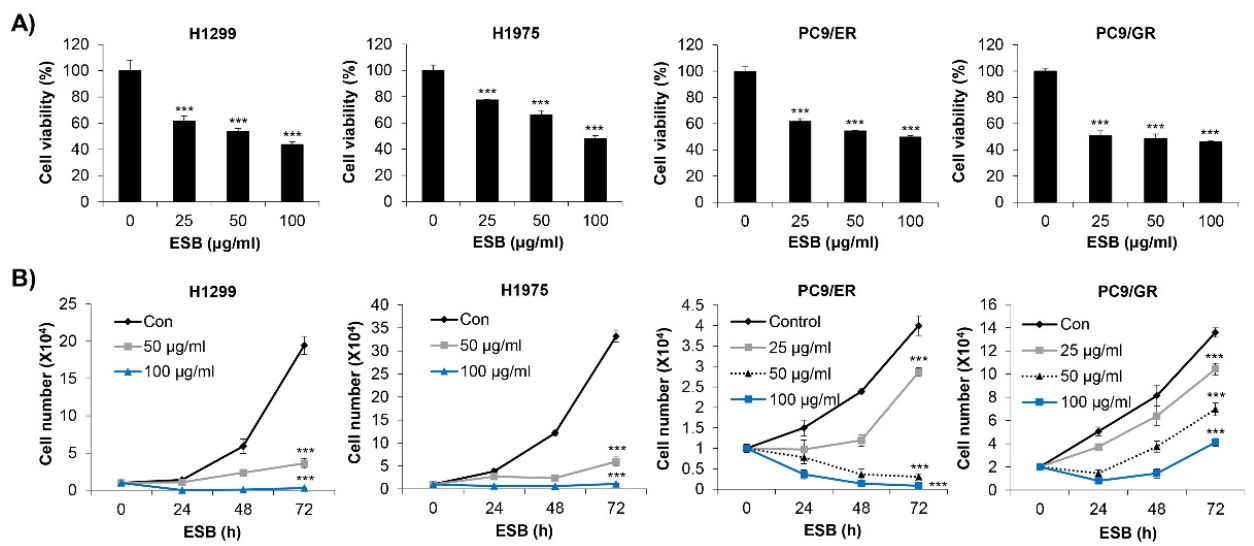
Figure 3. Effect of ESB on the cell growth of EGFR TKI-resistant human NSCLC cell lines. ( A ) H1299 ( EGFR wildtype; EGFR TKI-resistant), H1975 (acquired TKI-resistant), PC9/ER (acquired erlotinib-resistant), and PC9/GR (acquired gefitinib-resistant) human NSCLC cell lines were treated with different concentrations of ESB for 72 h. Cell viability was measured by the MTT assay. ( B ) Cells were treated with the indicated concentrations of ESB for 24–72 h. The number of live cells was counted by the trypan blue exclusion assay. The data are expressed as the mean ± SD of three independent experiments. Significance was determined by the Student’s t -test (*** p < 0.001 vs. untreated controls). ESB, ethanol extract of the root of Scutellaria baicalensis; NSCLC, non-small-cell lung cancer; EGFR TKI, Epidermal growth factor receptor tyrosine kinase inhibitor; SD, standard deviation.